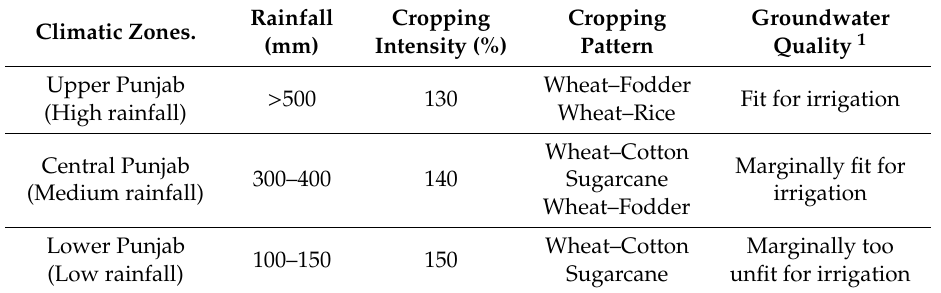
Table 1. Cropping patterns, cropping intensity and groundwater quality in different agro-climatic zones . Climatic Zones.